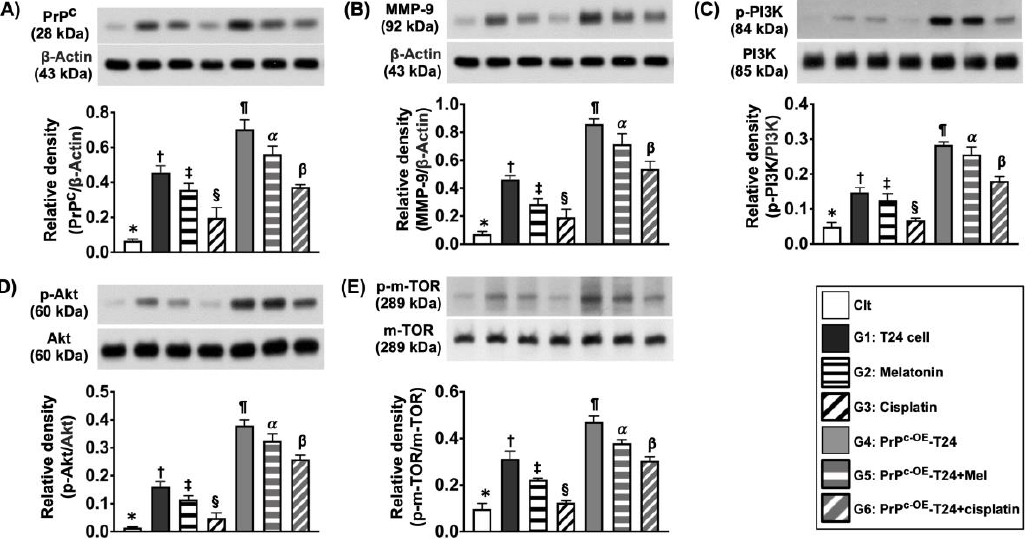
Figure 4. The protein levels of cell proliferation markers in different situations. ( A ) Protein level of PrP C : (1) * vs. different symbols (†, ‡, and §) and (2) ¶ vs. different symbols ( α and β ), all p values < 0.0001. ( B ) Protein level of phosphorylated (p)-PI3K: (1) * vs. different symbols (†, ‡, and §) and (2) ¶ vs. different symbols ( α and β ), all p values < 0.0001. ( C ) Protein level of p-Akt: (1) * vs. different symbols (†, ‡, and §) and (2) ¶ vs. different symbols ( α and β ), all p values < 0.0001. ( D ) Protein level of p-m-TOR: (1) * vs. different symbols (†, ‡, and §) and (2) ¶ vs. different symbols ( α and β ), all p values < 0.0001. ( E ) Protein level of MMP-9: (1) * vs. different symbols (†, ‡, and §) and (2) ¶ vs. different symbols ( α and β ), all p values < 0.0001. n = 6 for each group. Control (Clt) = V-HUC-1; G1 = T24 only; G2 = melatonin (Mel); G3 = cisplatin; G4 = PrP C overexpression in T24 cells (i.e., PrP C-OE -T24); G5 = PrP C-OE -T24 cells + Mel (100 uM treated for 24 h); G6 = PrP C-OE -T24 cells + cisplatin (6.0 uM treated for 24 h).